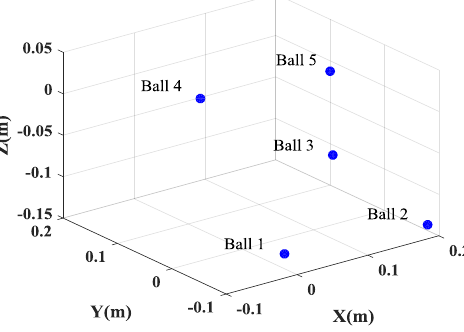
Figure 8. The height estimation from the generated SAR images by the multichannel joint CS method when 25% of full data is used.